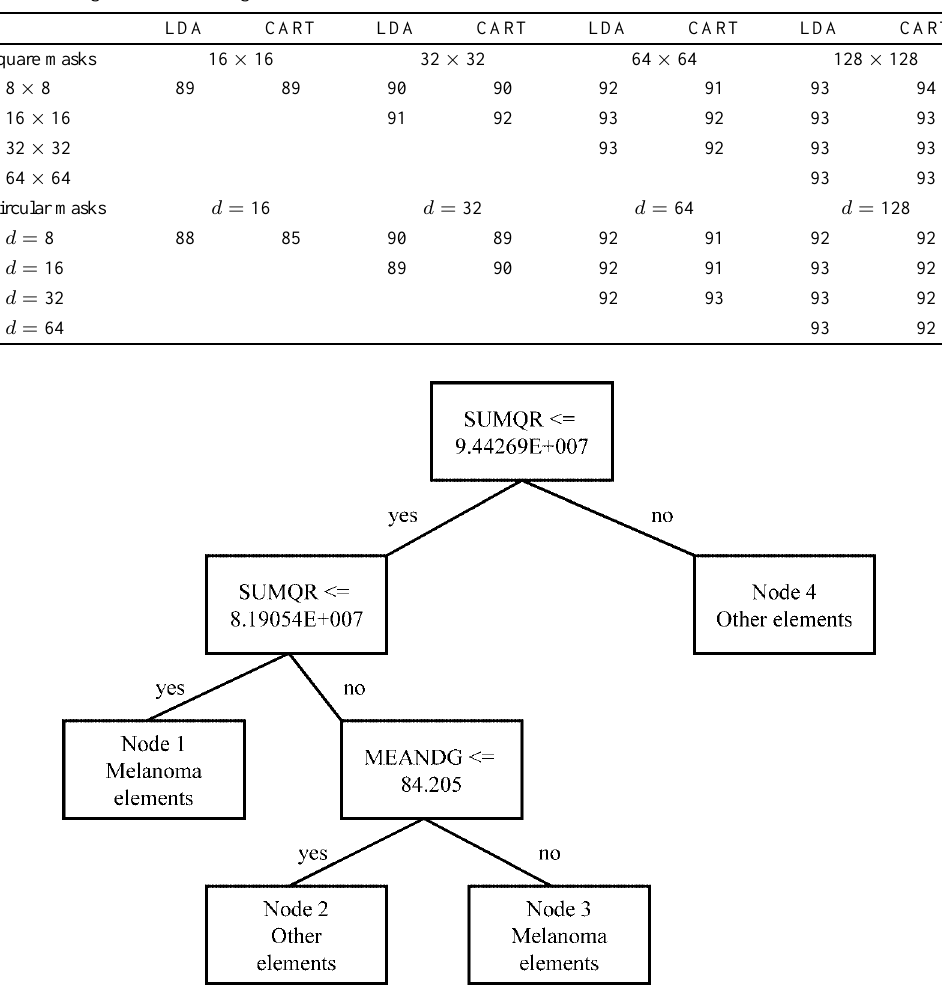
Percentage of correctly classified elements of melanoma tissue, other tissue components and background in haematoxylin– eosin-stained slides. Influence of the combination of measuring elements of different size ( n = 3000 elements per test; LDA: linear discriminant analysis; CART: classification and regression tree). There is no advantage compared to the use of a measuring elements of a single size